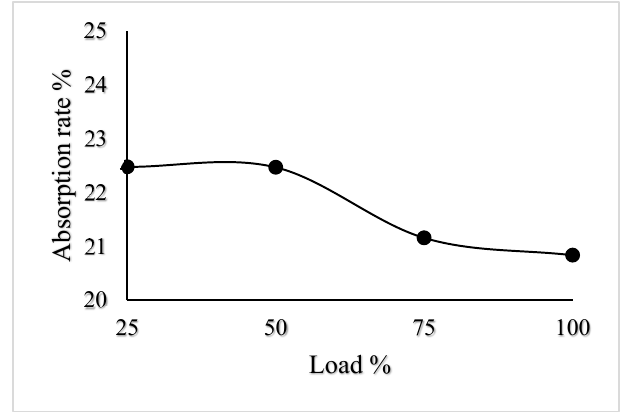
Figure 8. Experimental results at different load conditions.